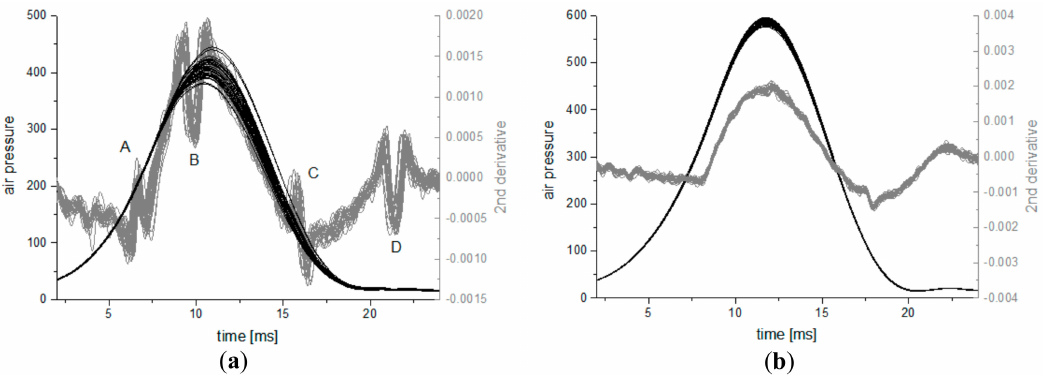
Figure 2. ( a ) Air pressure curves and their second derivative for 30 measurements on one participant (subject no. 1) and ( b ) 30 air pressure curves and their second derivatives for the rigid glass lens.